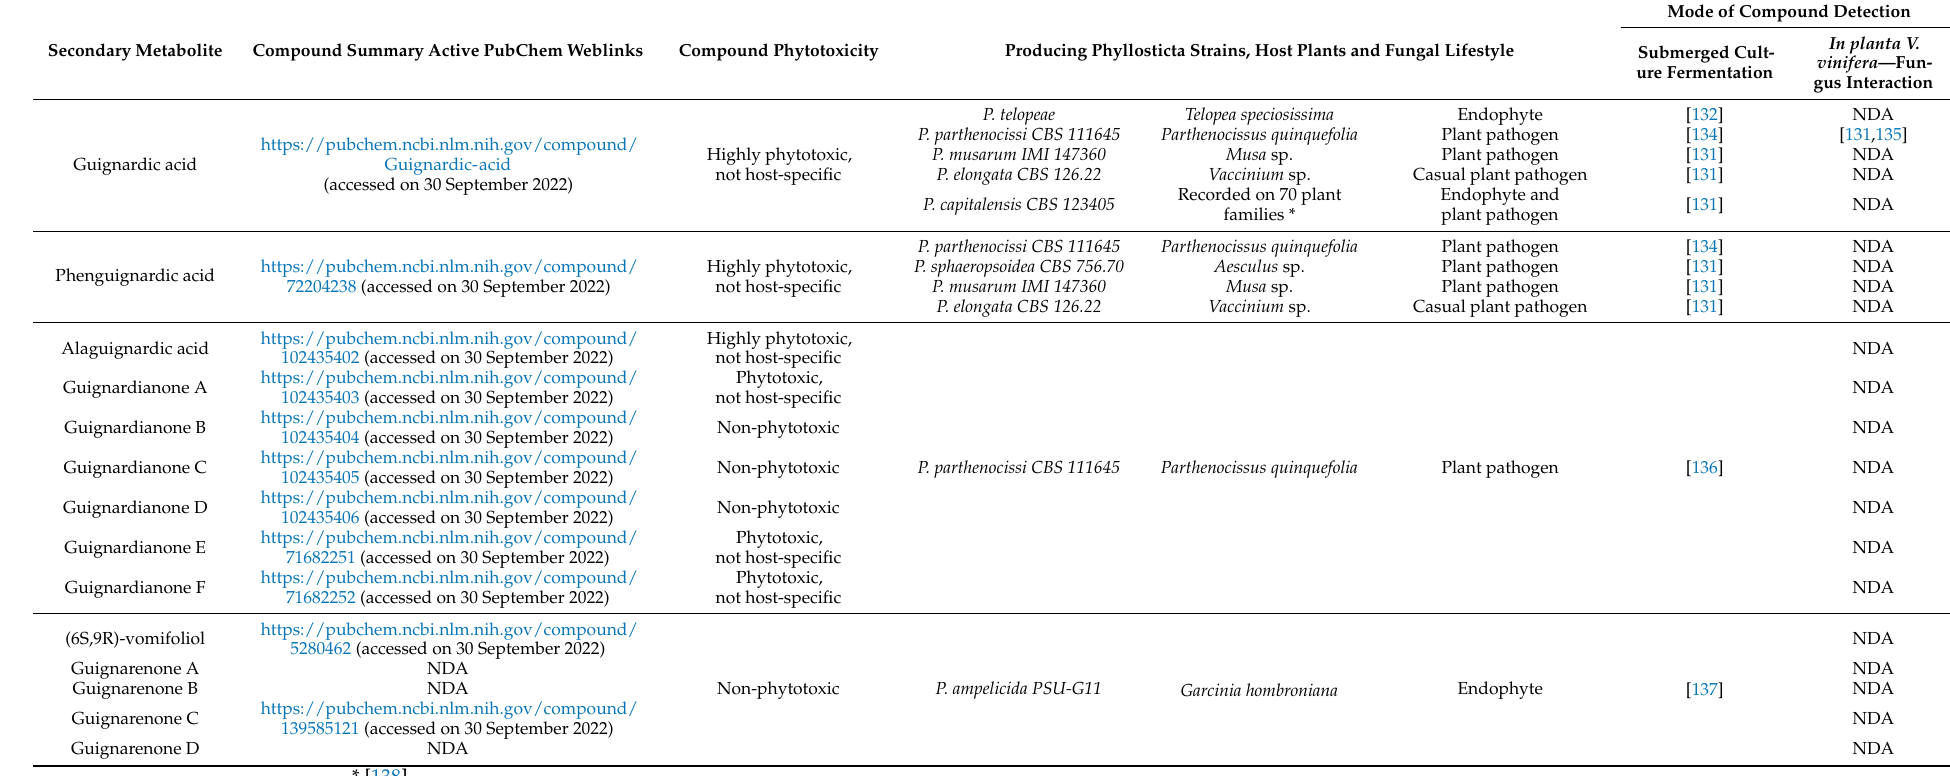
Table 2. Fungal secondary metabolites associated with grape black rot, published until